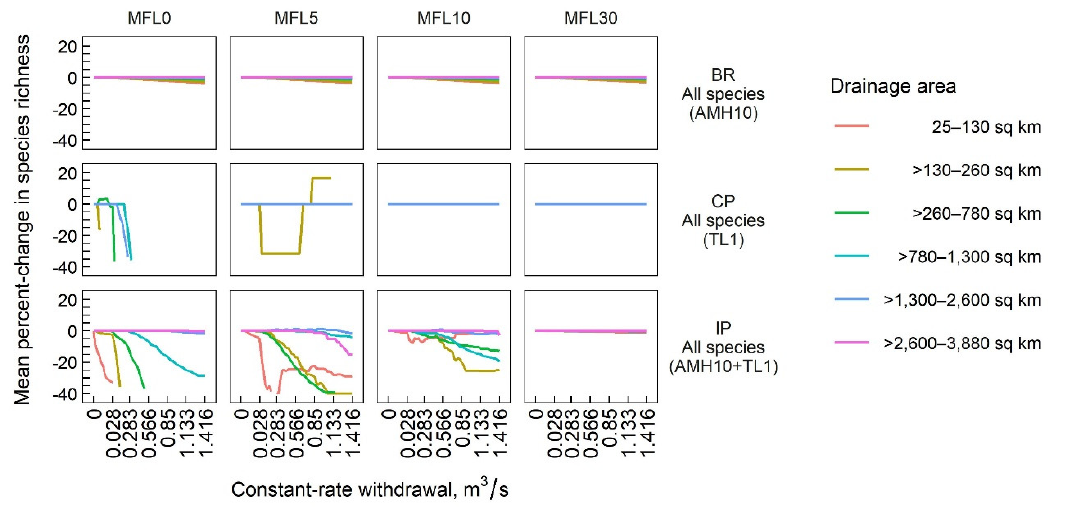
Figure 6. Patterns of mean percent change in fish species richness in response to incremental constant-rate withdrawal scenarios and minimum flow levels (MFL) for the “All Species” fish group for Blue Ridge (BR), Cumberland Plateau (CP), and Interior Plateau (IP) ecoregions. Solid lines represent individual stream sites. SFC(s) associated with the ecological limit function for each fish group and ecoregion are in parentheses.